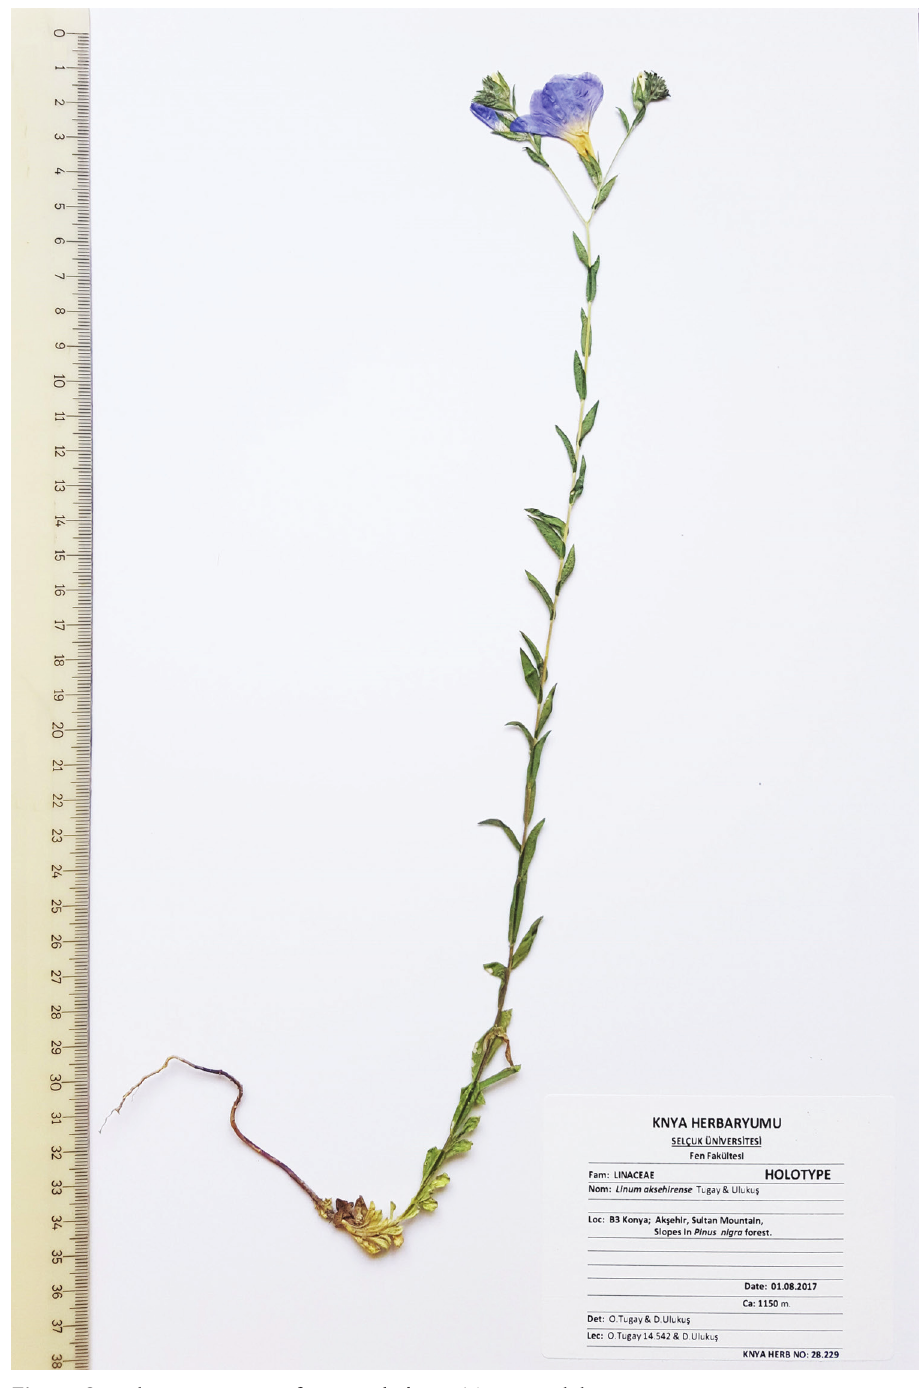
Figure 2. Holotype specimen of Linum aksehirense Tugay &